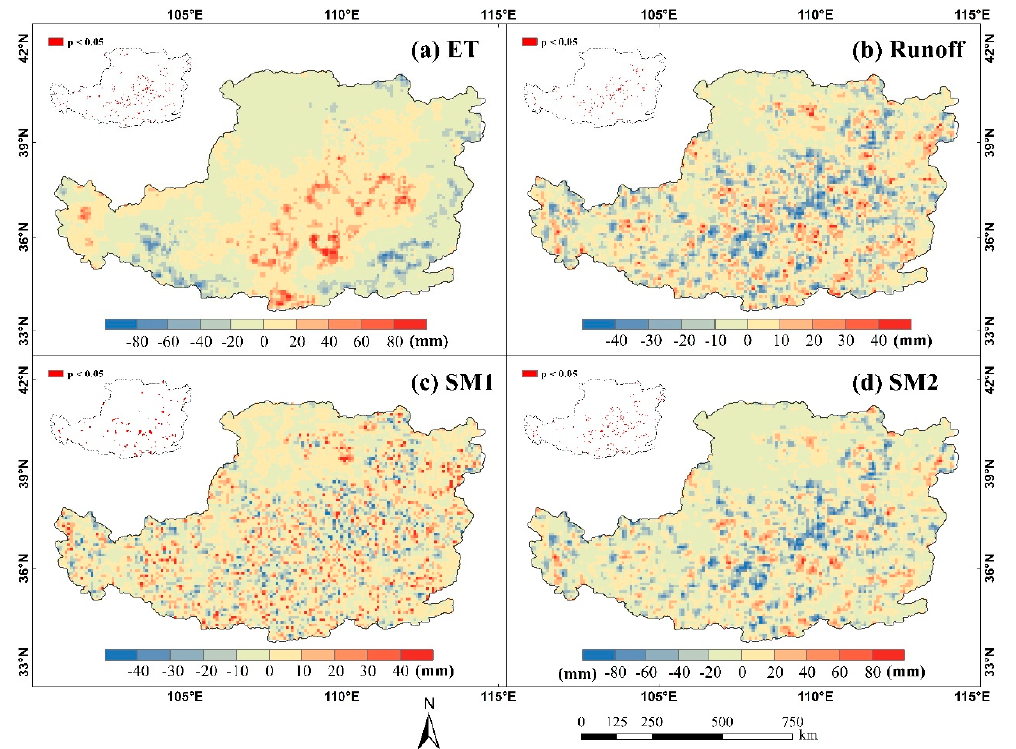
Figure 6. Spatial pattern of differences in the multi-year mean of four key HVs, ( a ) ET, ( b ) Runoff, ( c ) SM1, ( d ) SM2, simulated by VIC model during the two periods of 1984–1999 and